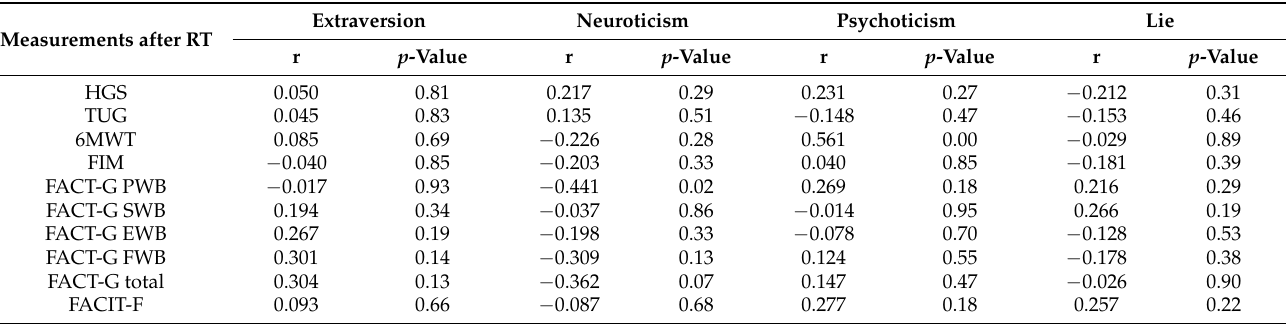
Table 5. Correlations between personality traits and results of fitness tests, quality of life, and level of fatigue assessed after RT.